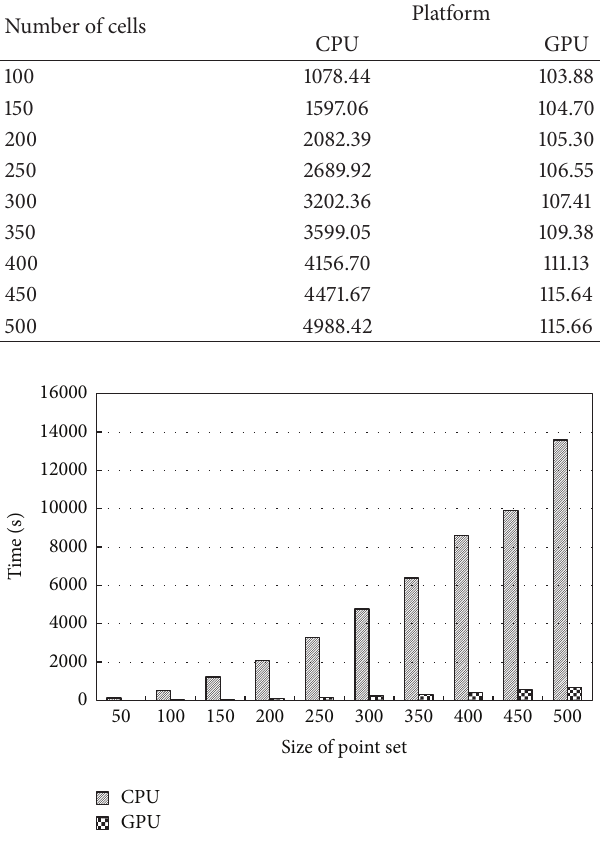
Figure 4: Runtime (s) of CPU and GPU implementation of the membrane algorithm having 200 cells on the point set matching problem with different sizes of point